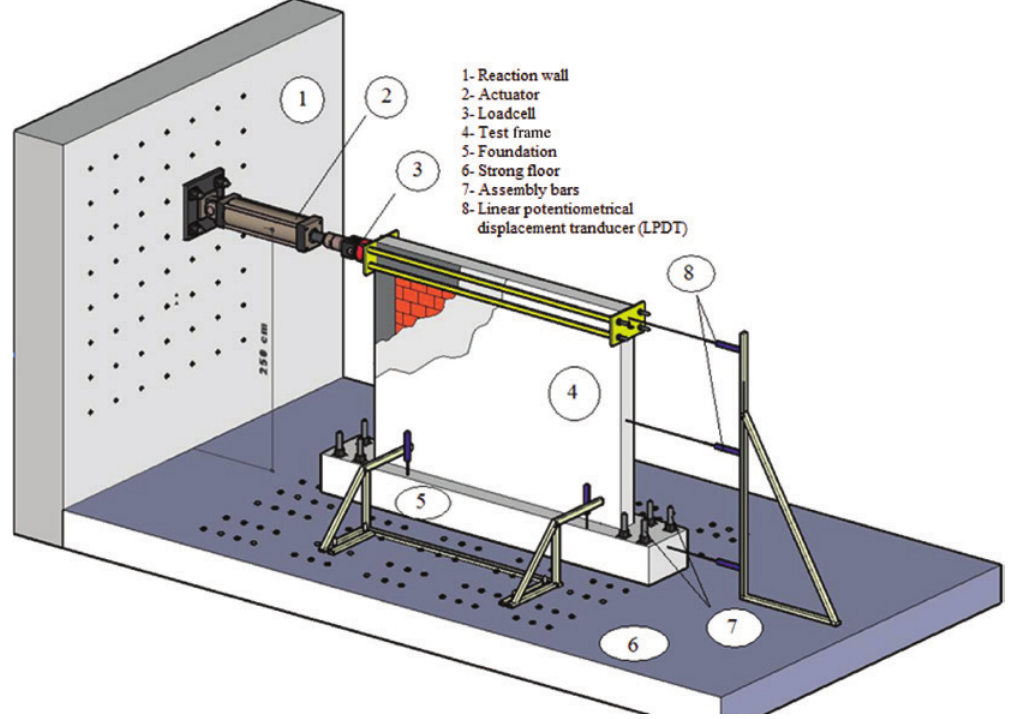
Figure 4: Test set-up of reinforced concrete (RC) frames.